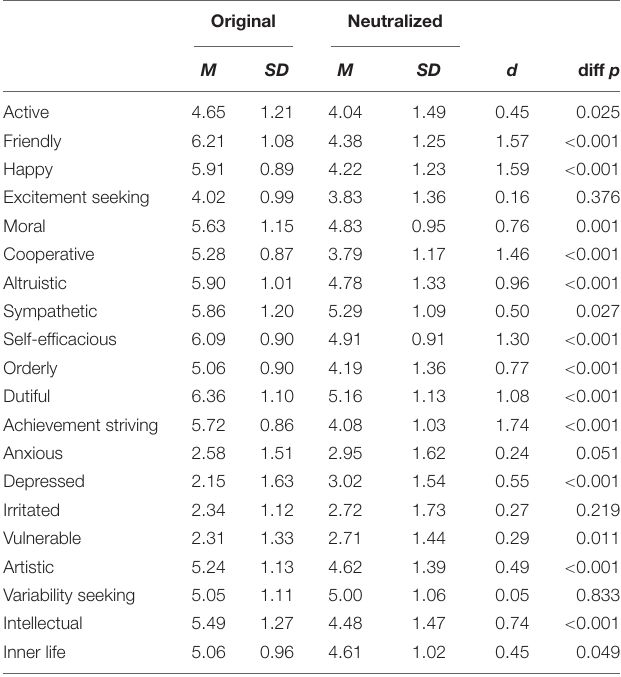
TABLE 1 | Means, standard deviations, and p -values for the social desirability ratings of the original IPIP-300 scales and neutralized versions.